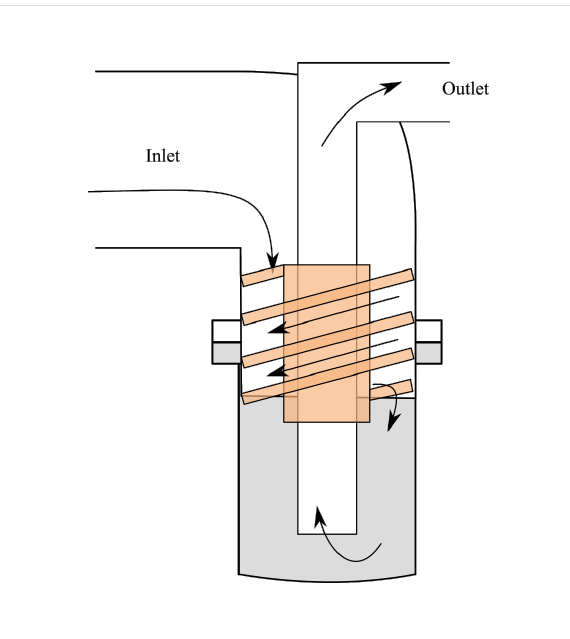
Figure 5: System for the product recovery: the cyclonic separator for vacuum (orange) and the interchangeable vessel (grey).